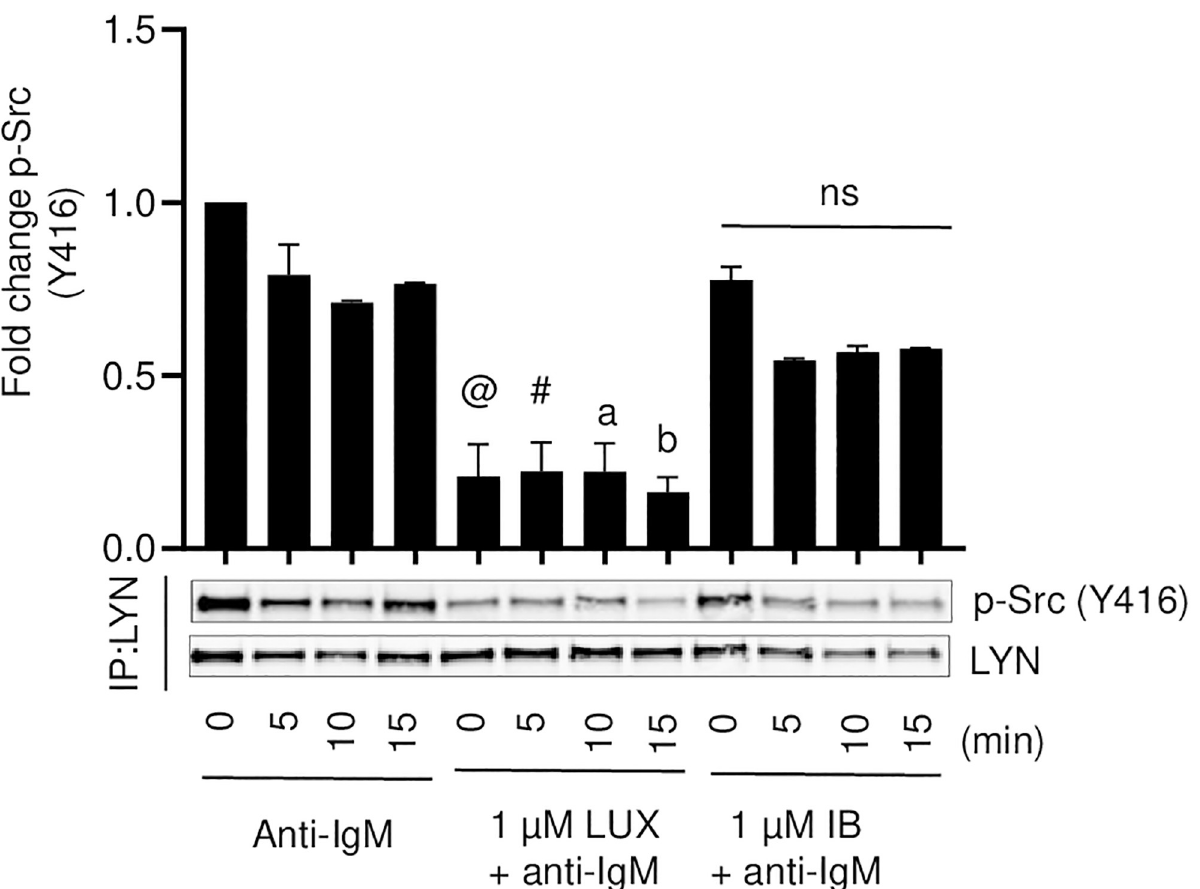
Fig 5. Effect of LUX and IB on anti-IgM-induced phosphorylation of LYN in SU-DHL-6 cells. Cells were pre-treated with vehicle or 1 μ M LUX or IB after which they were stimulated with anti-human IgM. LYN immunoprecipitates from these cells were analyzed using antibodies for phospho-Src (Y416) and LYN at the indicated time points in SU-DHL-6 cells. Histograms show quantification of phospho-Src (Y416) band intensity relative to that of LYN. Data is mean ± SEM of data from 2 independent experiments. In the LUX + anti-IgM stimulated group, a statistically significant inhibition of p-Src (Y416) is denoted by @ (p < 0.0001), # (p = 0.0003), a (p = 0.001), b (p = 0001) when compared to the respective time point for the anti-IgM stimulated cells. No significant inhibition of p-Src (Y416) was observed in the IB + anti-IgM group when compared to the respective time point for the anti-IgM stimulated